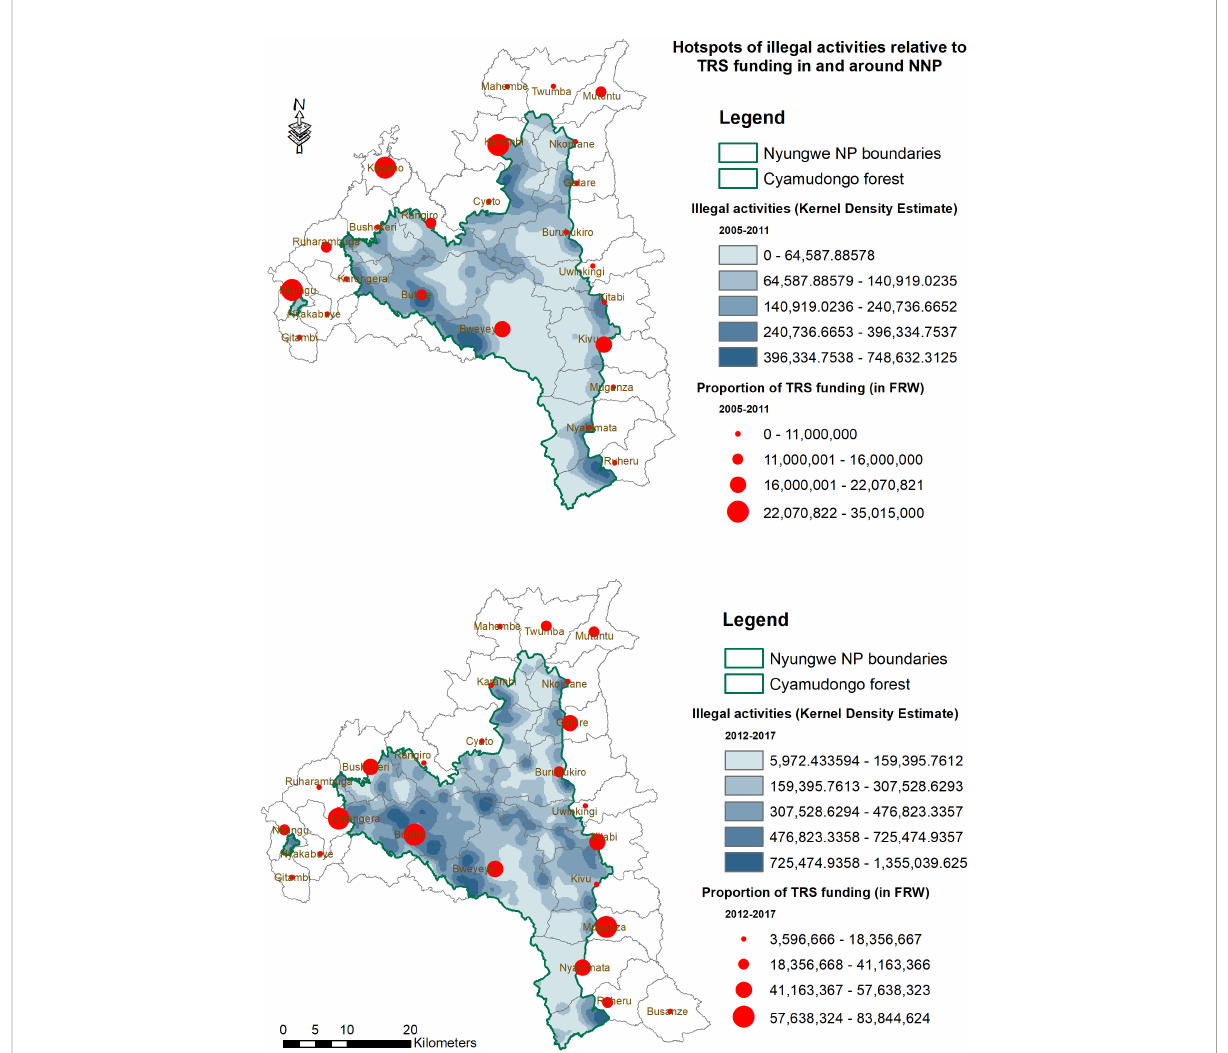
FIGURE 3 Hotspots of illegal activities in Nyungwe National Park relative to tourism revenue sharing funding to sectors bordering the park from 2005- 2017, split into two periods 2005-2011 and 2012-2017. NNP, Nyungwe National Park; TRS, tourism revenue sharing; FRW, Franc Rwandais. Data source: Rwanda Development